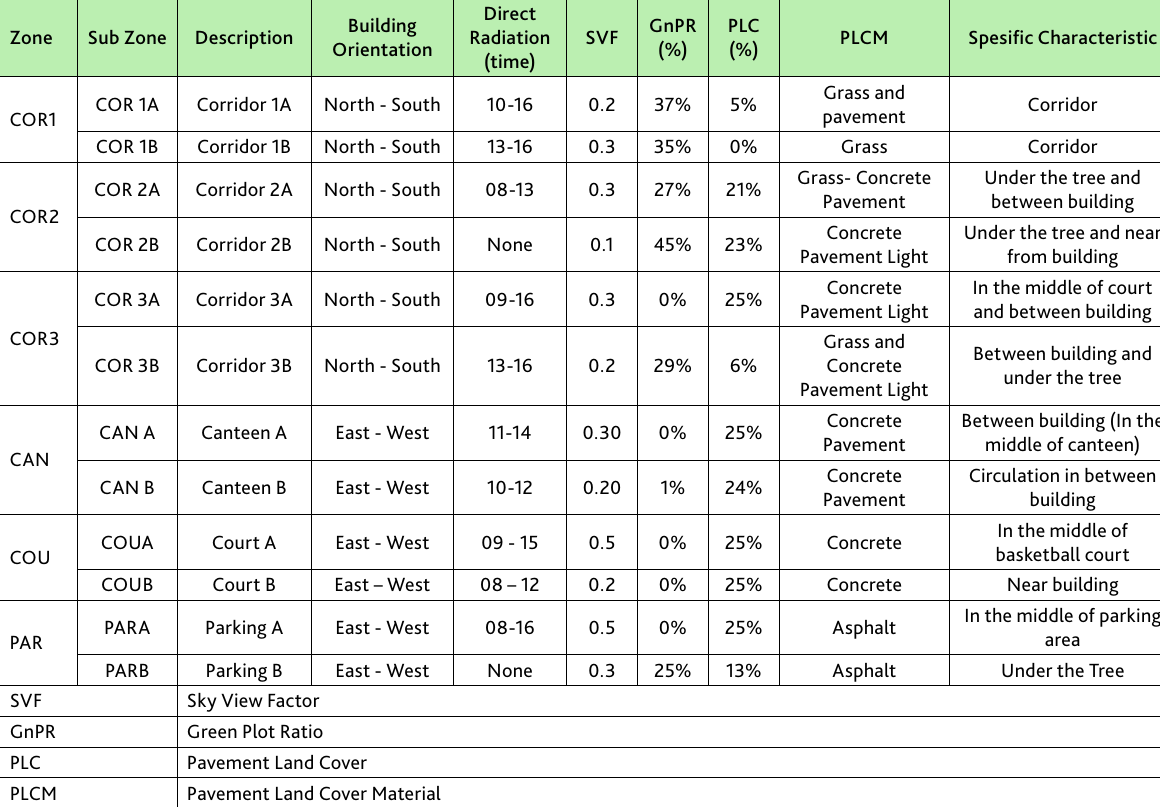
Table 3. The outdoor zone division is based on different characteristics.